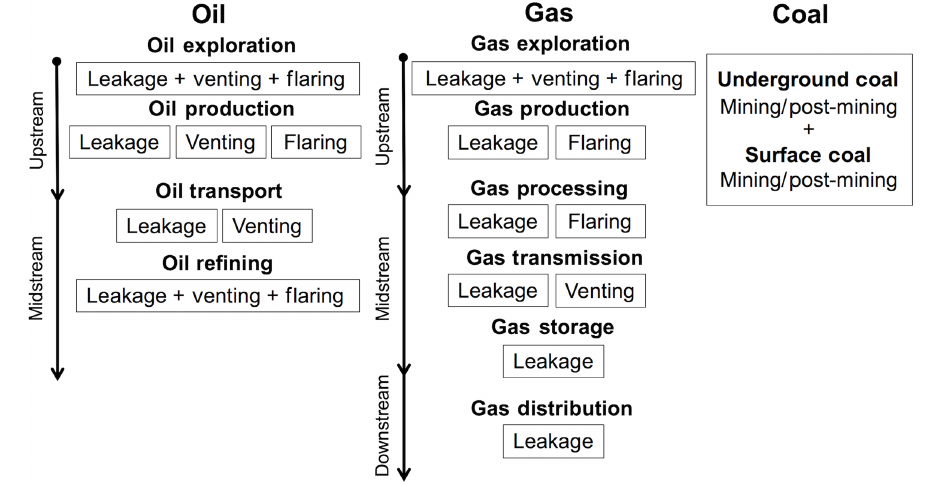
Figure 1. Methane emissions from oil, gas, and coal as resolved in our inventory. Emissions for oil and gas are separated into subsectors representing the different life cycle stages. Each box in the figure corresponds to a separate 0 . 1 ◦ × 0 . 1 ◦ gridded product in the